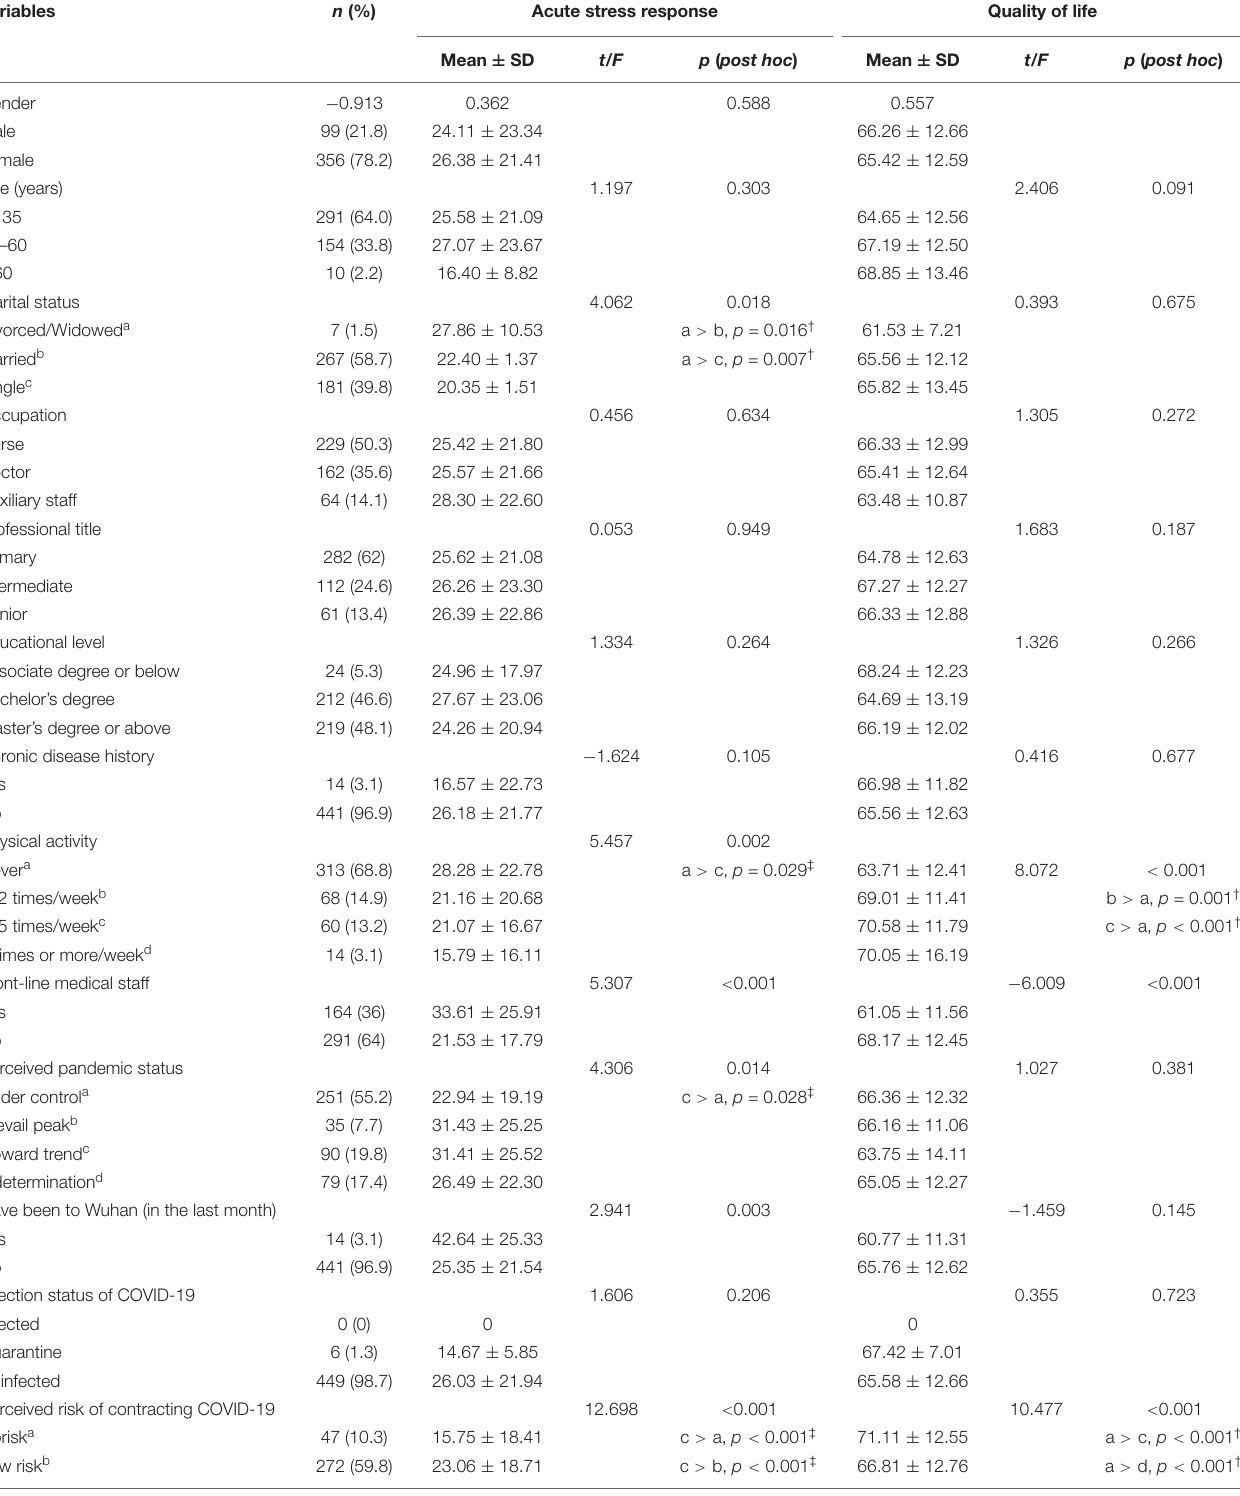
TABLE 1 | Univariate analysis of acute stress and quality of life with demographic ( n = 455). Variables n (%) Acute stress